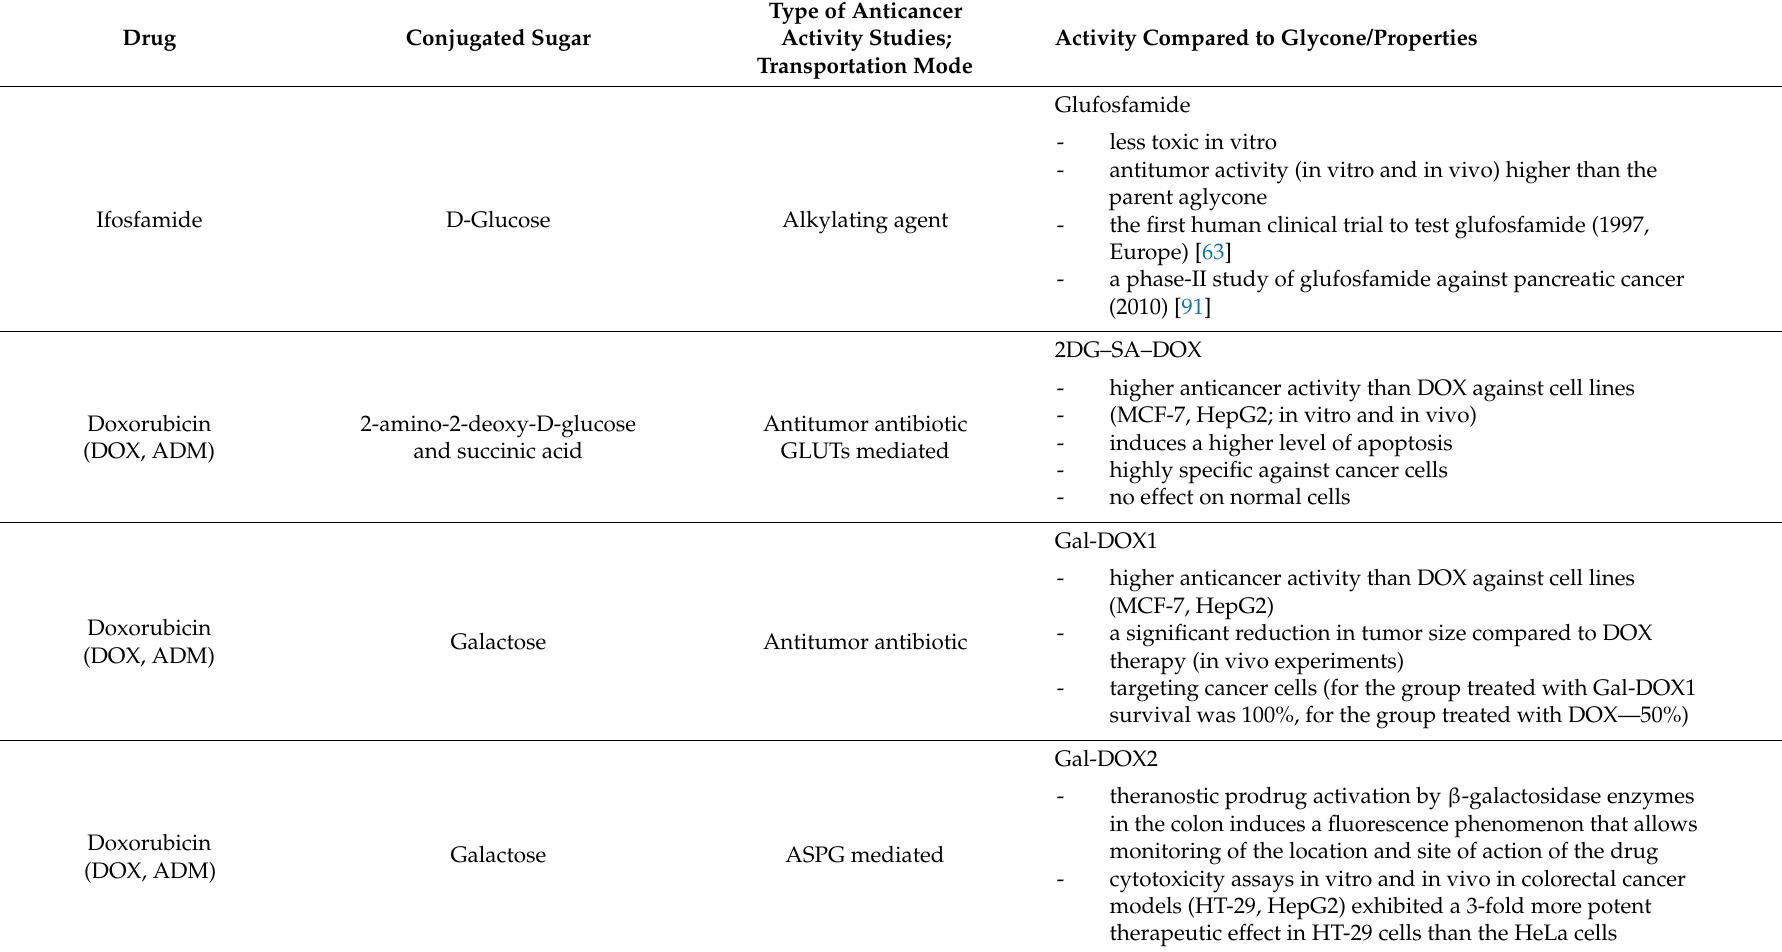
Table 1. Representative anticancer drug